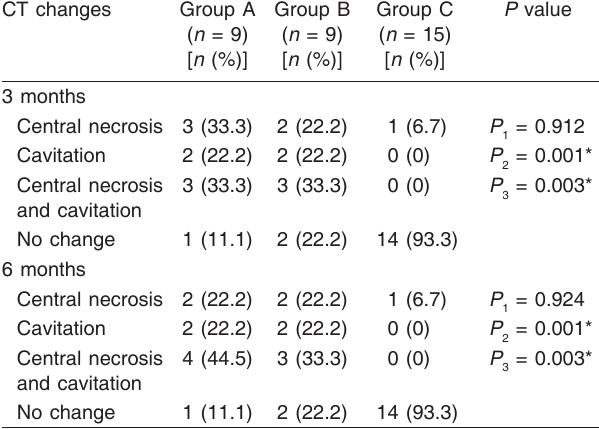
Table 2 Computed tomographic morphological changes in the tumor mass after 3 and 6 months of